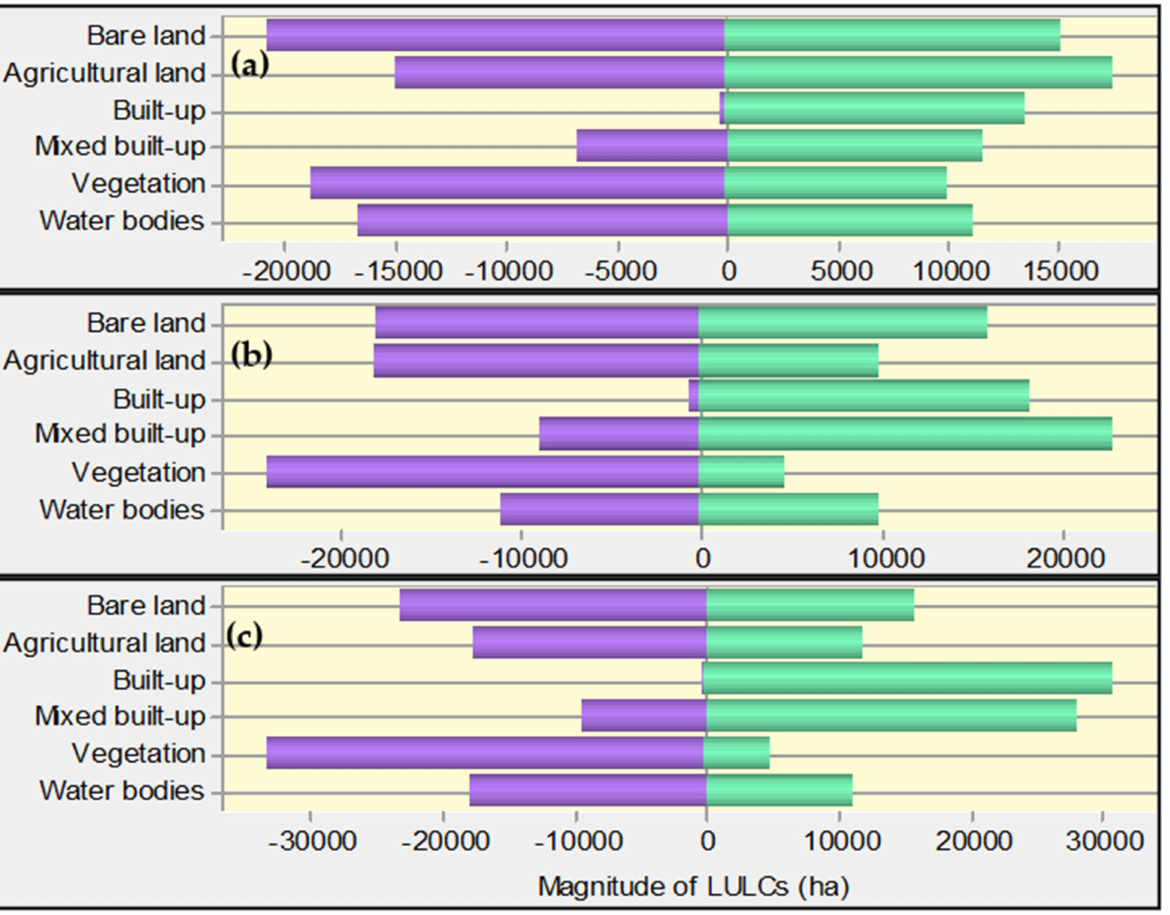
Figure 5. Magnitude (ha) of gains and losses in the LULCs of KMA; ( a ) gains and losses between 1996 and 2006, ( b ) gains and losses between 2006 and 2016, and ( c ) gains and losses between 1996 and